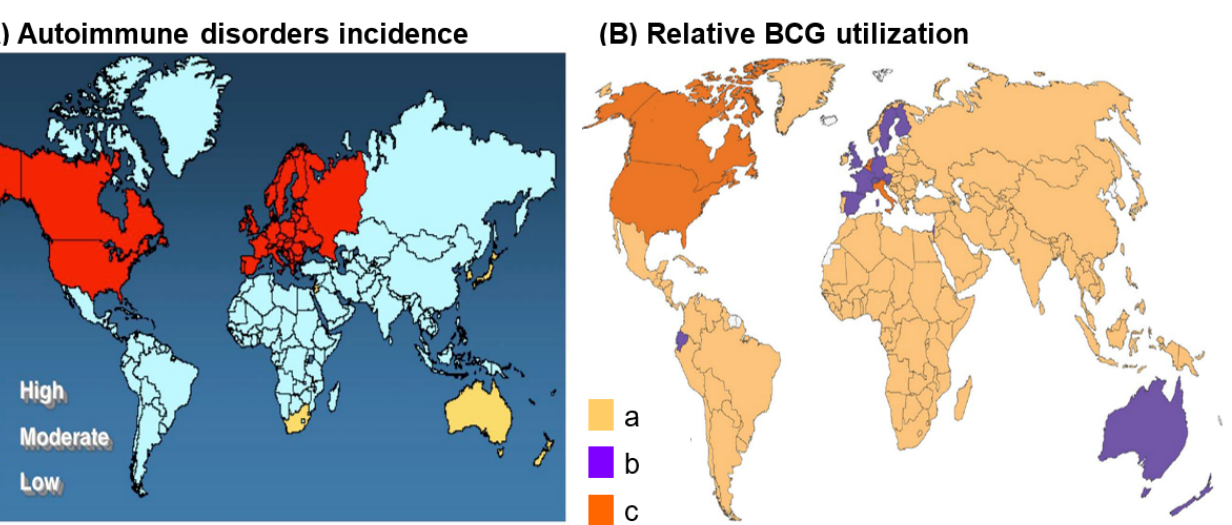
Figure 2. World maps displaying the relative incidence of autoimmune disorders and relative BCG utilization. ( A ) World map displaying the relative incidence of autoimmune disease in 2017. Note that the incidence is greatest in the U.S., Canada, and western Europe, followed by Australia and South Africa (https://forums.phoenixrising.me/threads/autoimmune-disease-prevalence-in-the- western-world.51642/ Accessed on 22 September 2022). Permission granted by original author, Joel Weinstock–Tufts Medical Center. ( B ) World map displaying the utilization of BCG. a: Countries with current universal BCG vaccination program. b: Countries that used to recommend universal